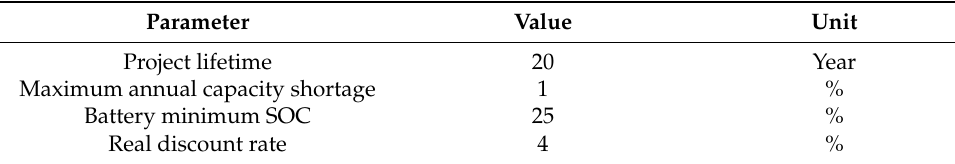
Table 4. Critical input parameters.